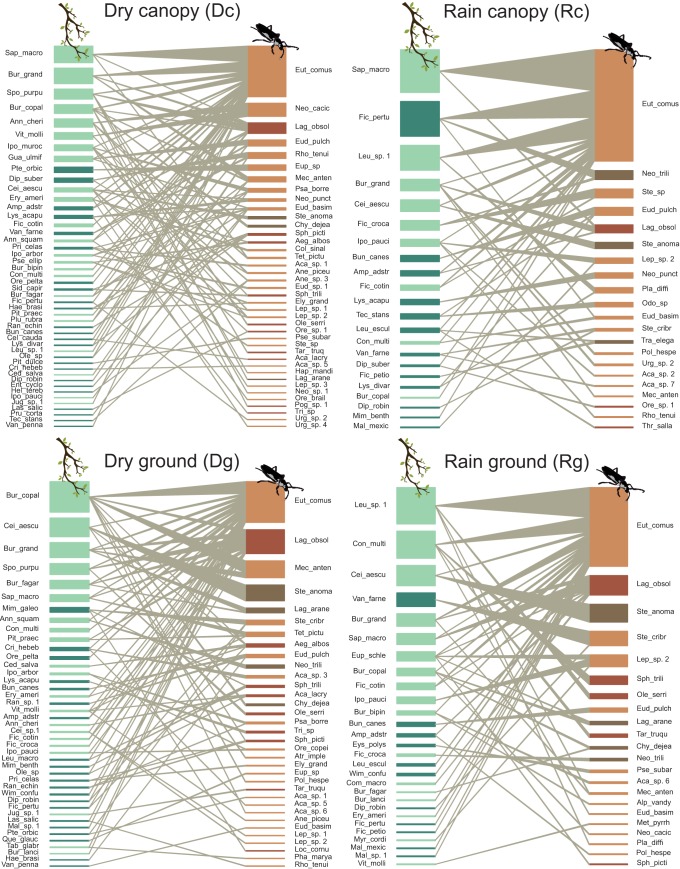
Cerambycidae-host tree interaction networks of four treatments: Rain canopy (Rc), Rain ground (Rg), Dry canopy (Dc) and Dry ground (Dg) in a tropical dry forest.The nodes of the Cerambycidae are represented by different brown tones: darker brown indicates a species with higher body size index and vice versa. Host tree nodes are represented by different green tones, darker green indicates tree species with harder wood and vice versa. The thickness of the links corresponds to the intensity of the interaction.